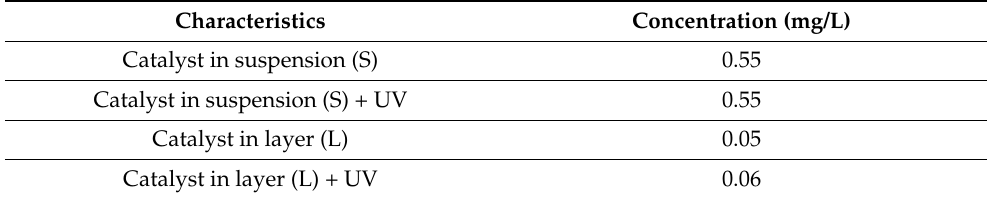
Table 3. Concentration of Zn in the permeate samples collected after each filtration